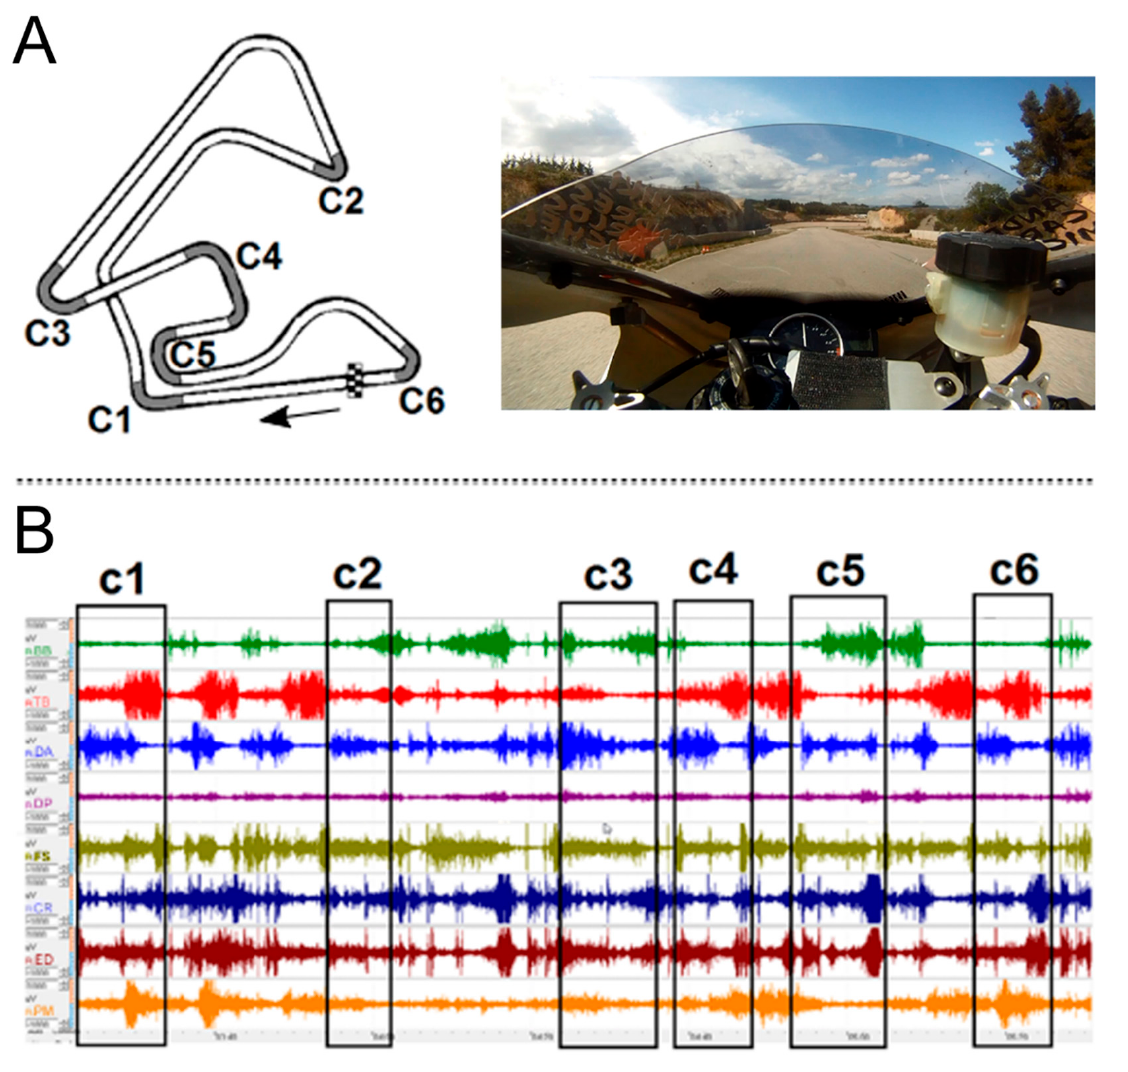
Figure 1. Section ( A ) shows the track layout and the most relevant curves. The layout of interest for each curve (beginning, apex and way out) is shaded in grey. Section ( B ) illustrates the registered sEMG signal of one lap and the analyzed sEMG sections corresponding to each curve.